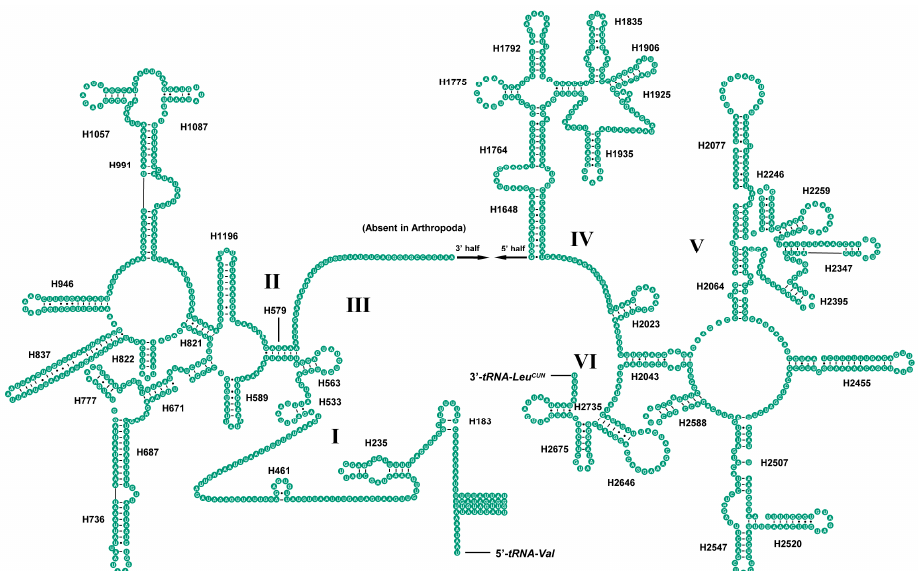
Figure 3. Predicted secondary structure of the lrRNA gene in S. teleckojensis . Roman numerals represent the conserved domain structures. Dashes (–) indicate Watson–Crick base pairings and dots ( • ) indicates G–U base pairing. I–VI indicate six domains in the secondary structure of lrRNA . Int. J. Mol. Sci. 2018 , 19 , x FOR PEER REVIEW The secondary structure of srRNA contained three domains (Figure 4). Similar to S. spinicercia , domain I was more variable than domains II and III, whereas Helix 1399 was the most conserved region [22]. In addition, S. teleckojensis possessed more nucleotides in Helix1068, Helix1074, and Helix 577.